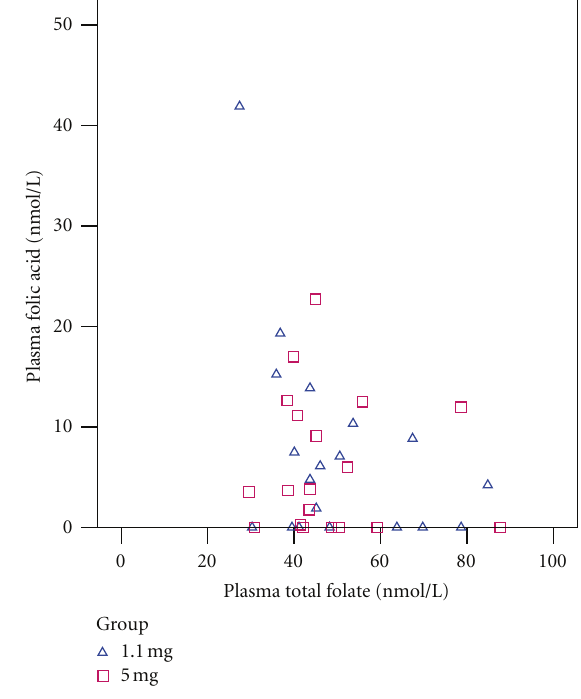
Figure 4: Relationship between plasma folic acid and plasma total folate. 1.1 mg group (triangles): Kendall’s τ b = − 0 . 26, P = 0 . 14. 5mg group (squares): Kendall’s τ b = − 0 . 073, P = 0 . 67. Pooled data: Kendall’s τ b = − 0 . 16, P = 0 . 18.